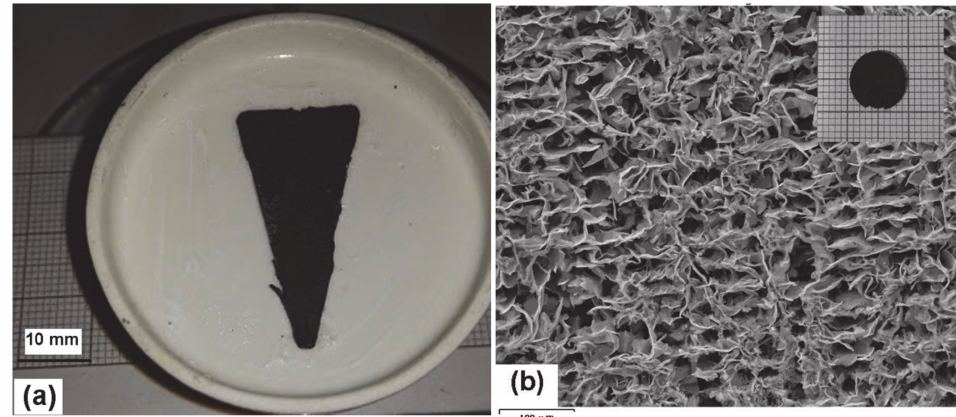
Figure 2. ( a ) Monolithic wedge; ( b ) aero-eutectic graphite (AEG) extracted from laminar graphite Type D (LDG) with insert on the upper right with the dimension of electrode of Li-O 2 battery. Figure 3 corresponds to AEGs of LAG and CG that were obtained after the chemical attack, while Figure 4 shows the AEG from LDG that was probed in Li-O 2 . The transition between zones with different spacing, as shown in Figure 4c, is explained in the next section, called Discussion.